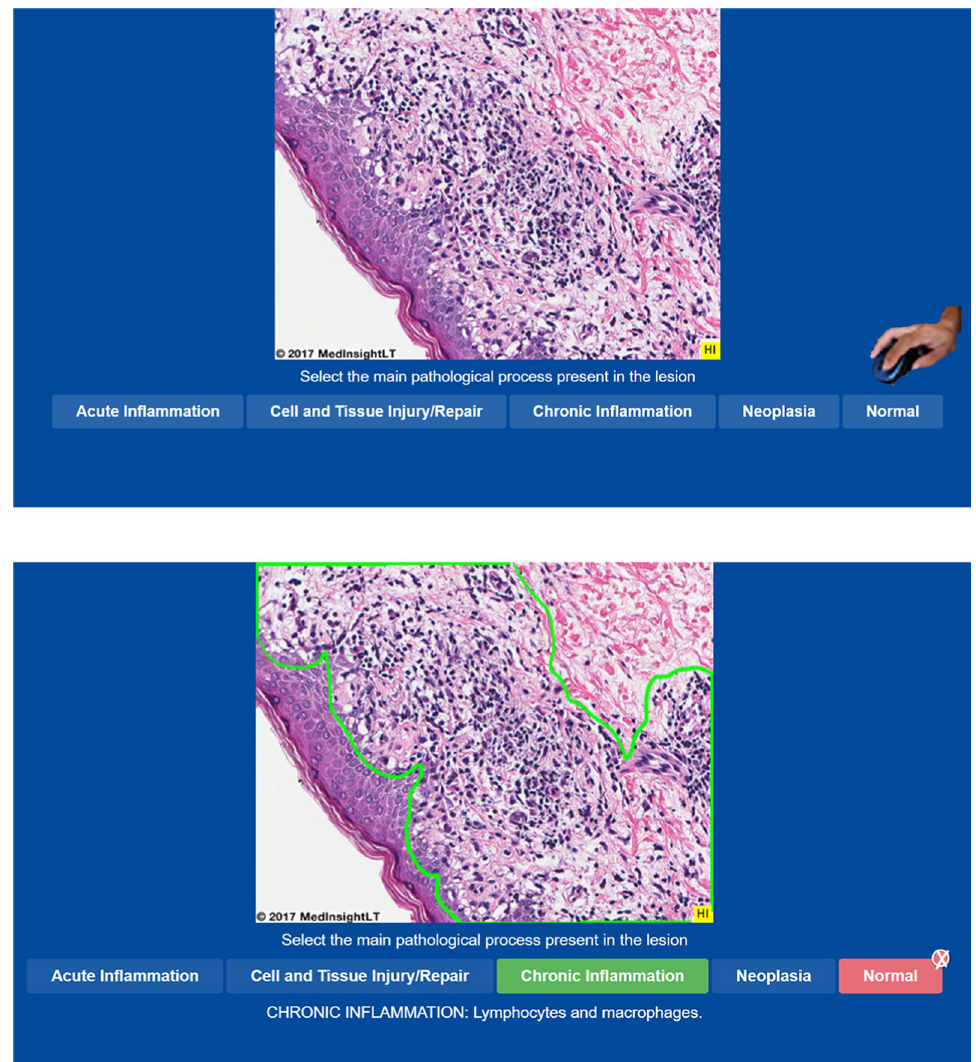
Fig. 2 Schematic of perceptual learning. Participants saw a histology image and made a judgment of its category. They then received feedback on their answer. If the image was one of the four histopathology categories, the area of pathology was then